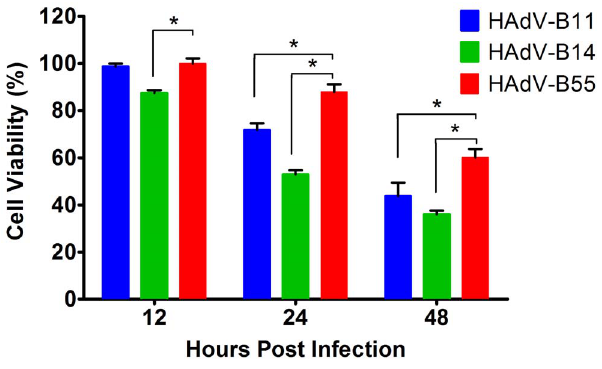
Figure 3. Toxicity of HAdV-B55, HAdV-B14 and HAdV-B11 in A549 cells. A549 cells were infected with one of the three viruses at an MOI of 10. At 12, 24 and 48 h post-infection, the results were assessed using MTS Cell Proliferation reagent (Promega) according to the manufacturer’s instructions. The resulting values (the ratio of infected to uninfected cells) are presented as the mean 6 standard deviation of four replicates. These results are representative of two independent experiments. The asterisks indicate statistically significant (P , 0.001) differences, as determined using two-way ANOVA tests.